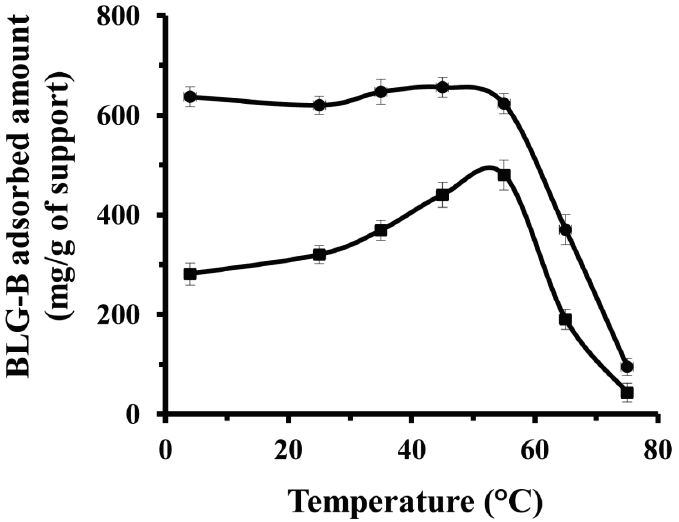
Figure 3. Effect of temperature on the adsorption amounts of BLG-B on KIT-6 ( ■ )